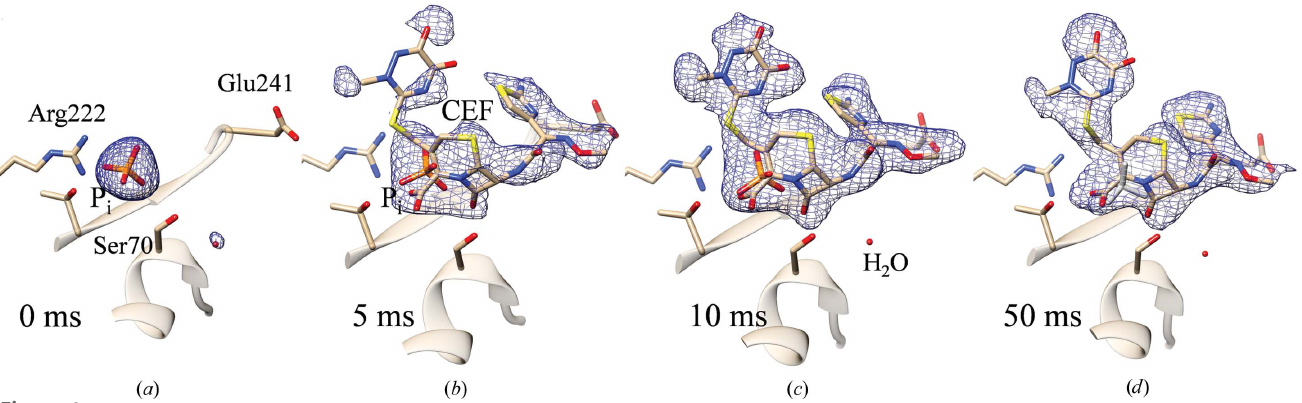
Figure 4 Polder difference electron density, contour level 3 (cid:6) , in the active center of BlaC subunit B . ( a ) The CEF ligand has not yet diffused in; the phosphate (P i ) from the crystallization buffer is dominant in the active site. ( b ) 5 ms after mixing: the phosphate is beginning to be displaced by CEF. ( c ) 10 ms after mixing: the phosphate is no longer dominant. ( d ) 50 ms after mixing: little evidence of the phosphate remains and the density only has features of the antibiotic compound. Nearby amino acids are marked in ( a